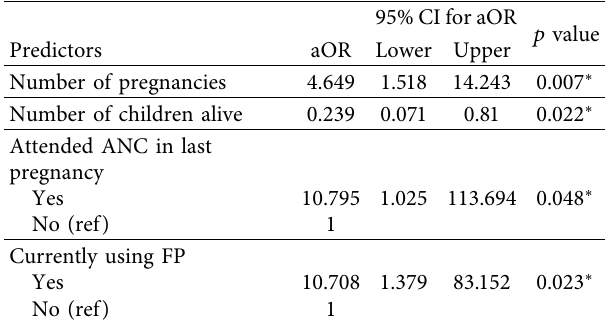
Table 2: Factors associated with postnatal care for mothers in URR, Gambia.